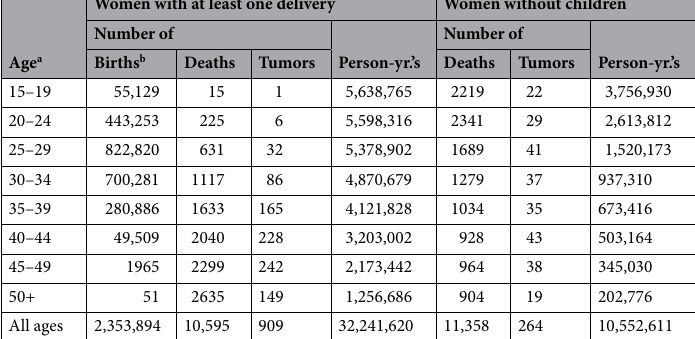
Table 2. Person-years of follow-up and the number of births, deaths, and meningioma tumors in 5-year age groups, respectively. Women with at least one delivery and women without children during the follow-up period 1973–2015. a Attained age at delivery, death or tumor diagnosis. b Multiple births are counted as one